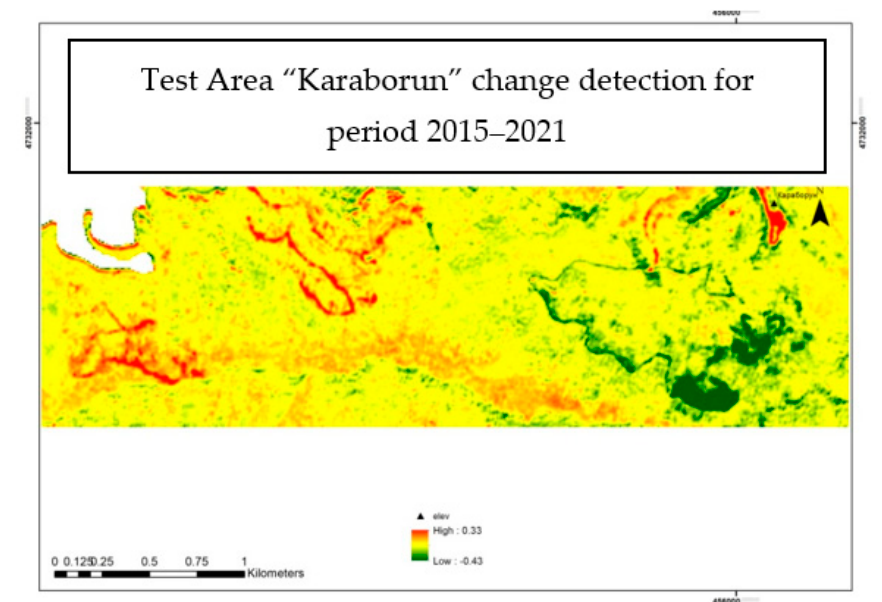
Figure 6. Map of change detection in forest vegetation for the period of 2015–2021.